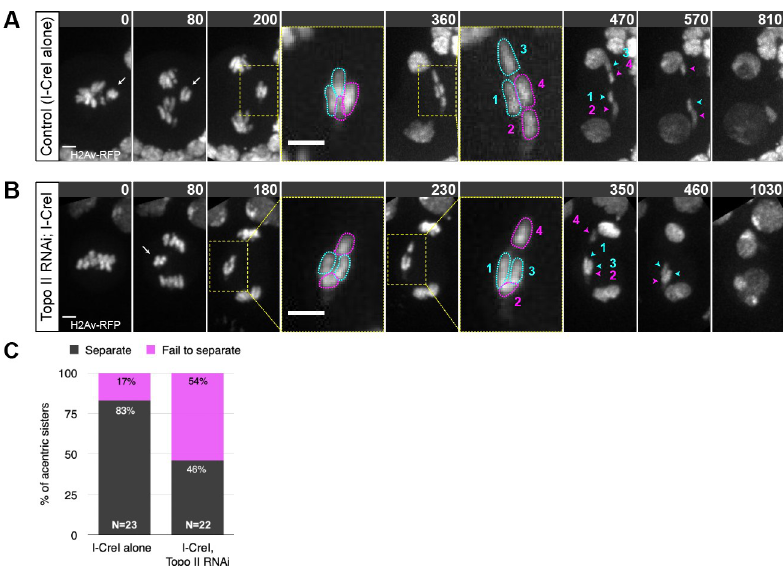
Fig 6. Acentrics appear to be held together by DNA catenations. (A) Still images of a time- lapse movie of a control neuroblast with I-CreI induced acentrics showing sister acentrics associated in early anaphase (white arrows), lagging behind and ultimately separating and segregating to opposite poles (cyan and magenta arrowheads). (B) Still images of a time-lapse movie of a neuroblast with partial knockdown of Topoisomerase II using RNAi and I-CreI induced acentrics. Acentrics associate and lag behind in early anaphase (white arrow), then fail to completely separate and segregate unequally (cyan and magenta arrowheads). Bars, 2 μ m. Time in seconds. (S4 Data) (C) Bar graph showing the quantification of acentric behavior in control and Topo II RNAi neuroblasts with the failure of acentric sister separation in magenta and the successful, even separation of acentric sisters in gray.